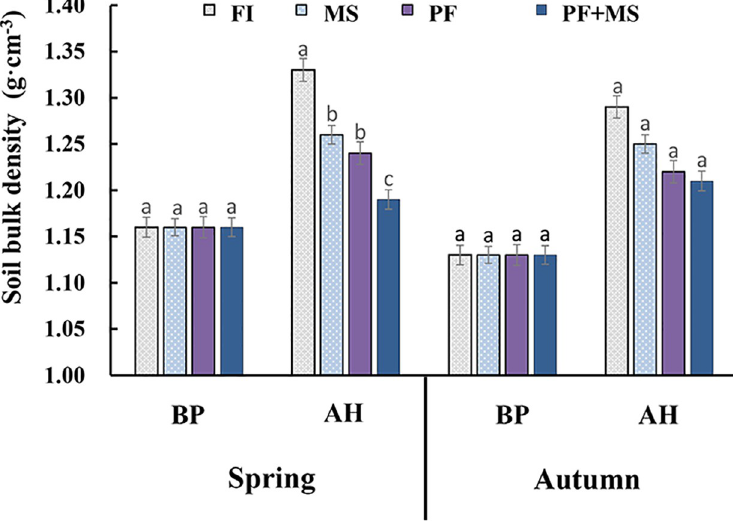
Fig 3. Effects of different irrigation systems on soil bulk density after harvest in spring or autumn. FI: Furrow irrigation; MS: Micro-sprinkler irrigation; PF: Plastic film mulching irrigation; PF+MS: Plastic film mulching-Micro- sprinkler irrigation (the followings are same). Values followed by different small letters are significantly different at p =